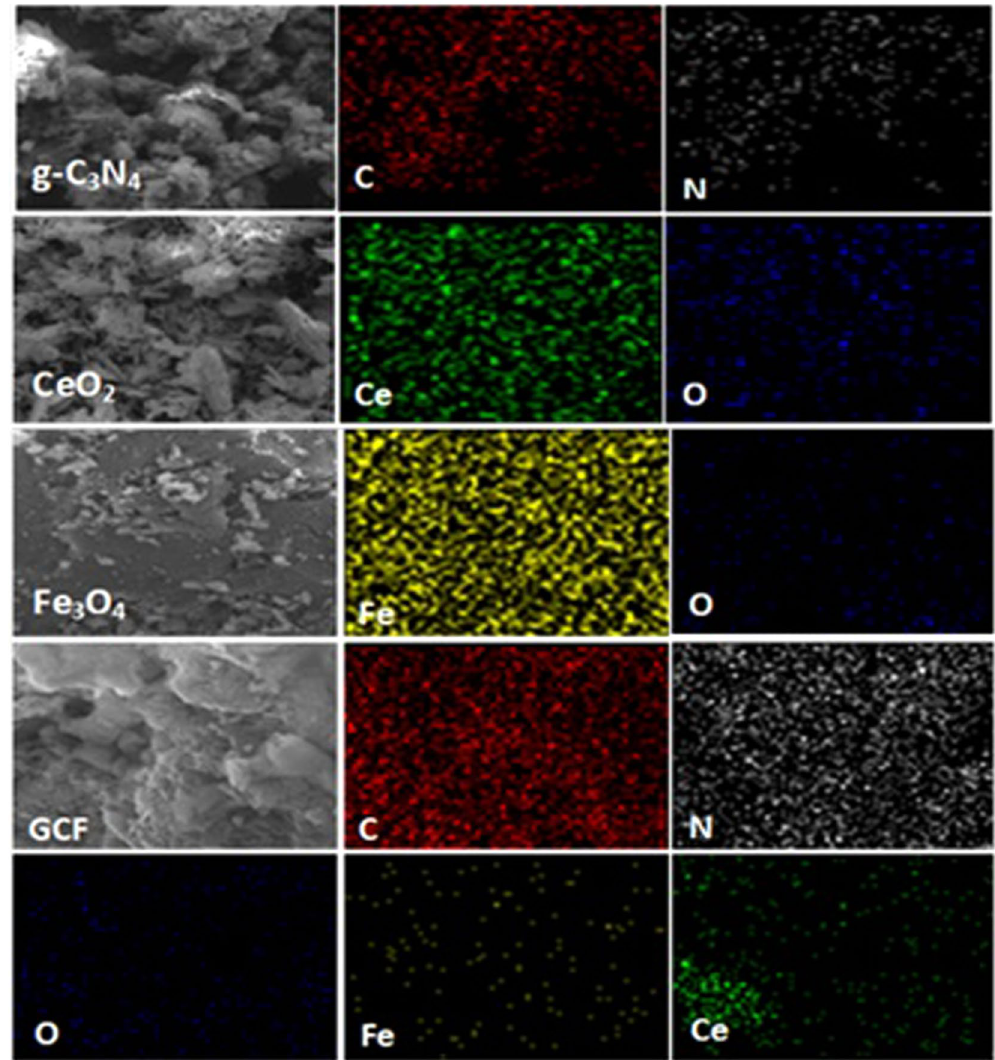
Figure 4. Elemental mapping of prepared pristine and nanocomposite photocatalysts.